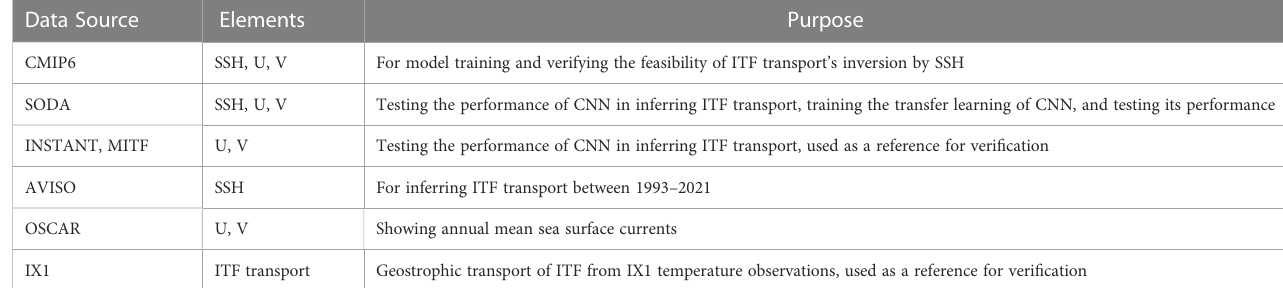
TABLE 2 Details of the CMIP6 models used in this study. CMIP6 model source